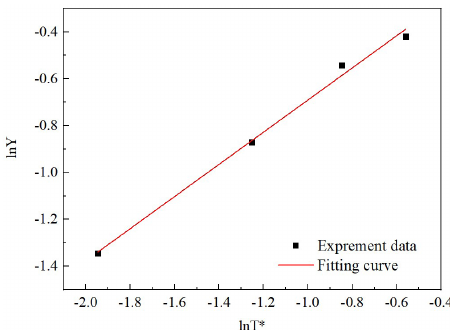
Figure 5. Determination of m -value.